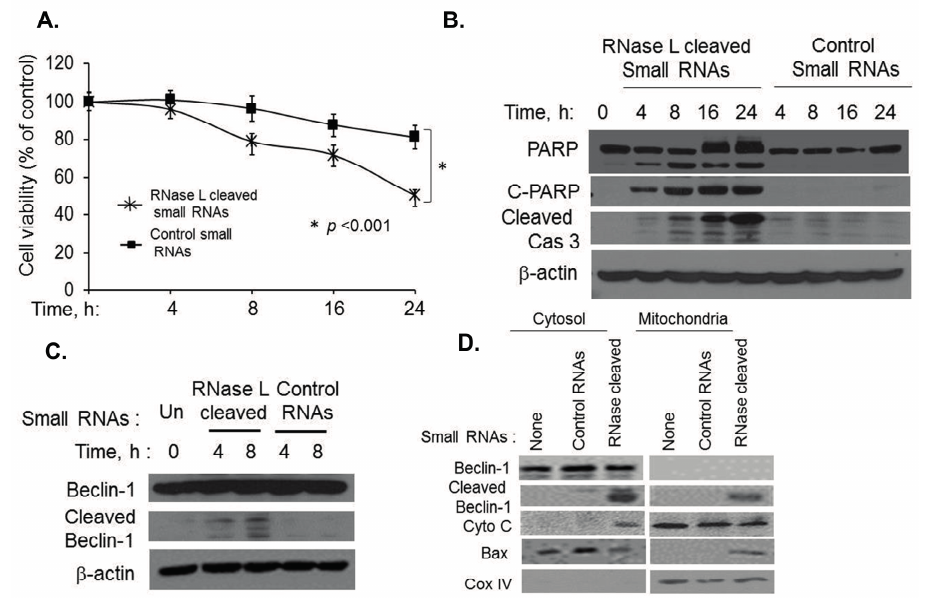
Figure 7. RNase L-generated small RNAs cleave Beclin-1 to promote switch from autophagy to apoptosis. HT1080 cells were transfected with 2 µg/mL of RNase L generated small RNAs or control RNAs (described in methods) for indicated times and ( A ) Cell viability was determined using MTT assay. Results are representative of